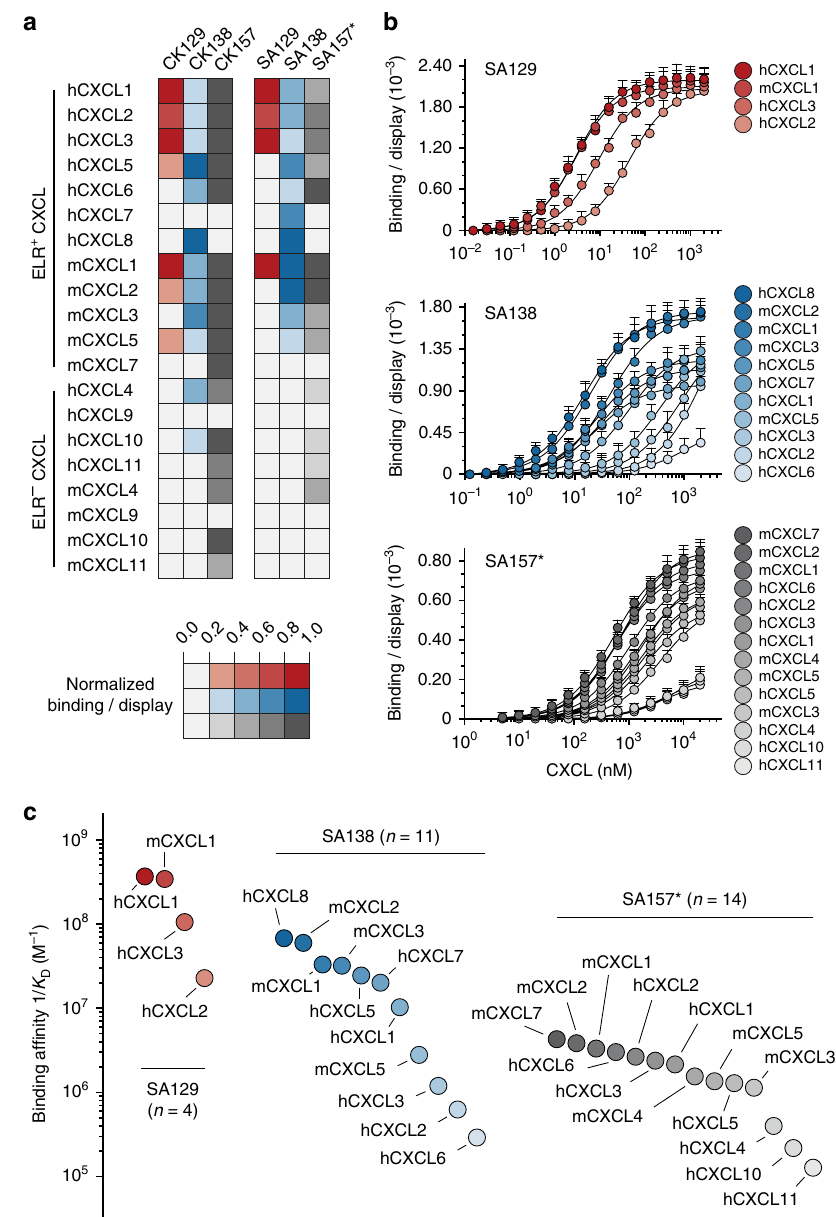
Fig. 4 Crossreactivity of engineered antibodies toward multiple CXC chemokines. a Heat map indicating the binding intensity of the engineered antibodies against 20 diverse human and murine CXC chemokines. Binding was assessed by fl ow cytometry using two cell-display arrangements: soluble CXC chemokine against yeast-displayed CK129 (red), CK138 (blue), and CK157 (gray) antibodies (on the left) and soluble serum albumin – antibody fusions SA129 (red), SA138 (blue), and SA157* (gray) against yeast-displayed CXC chemokines (on the right). Normalized binding/display signal intensities range from light to dark colors indicating low (0.0 ‒ 0.2) and high (0.8 ‒ 1.0) titers, respectively. b Binding isotherms of yeast-displayed CXC chemokines to soluble serum albumin – antibody fusions SA129, SA138, and SA157*. Equilibrium binding af fi nity ( K D ) values were determined only for chemokines exhibiting signals at high concentrations of soluble antibody fusions. CXC chemokines are gradient colored ranging from dark (high af fi nity) to light (low af fi nity) red (SA129), blue (SA138), and gray (SA157*). Data are presented as mean (dots)± s.e.m. (bars). c Plot showing binding af fi nities of yeast-displayed CXC chemokines to SA129 (red), SA138 (blue), and SA157* (gray) antibody fusions. The indicated values are displayed as differently colored fi lled circles and represent the means of at least three independent experiments presented as inverse equilibrium binding constants (1/ K D ; M − 1